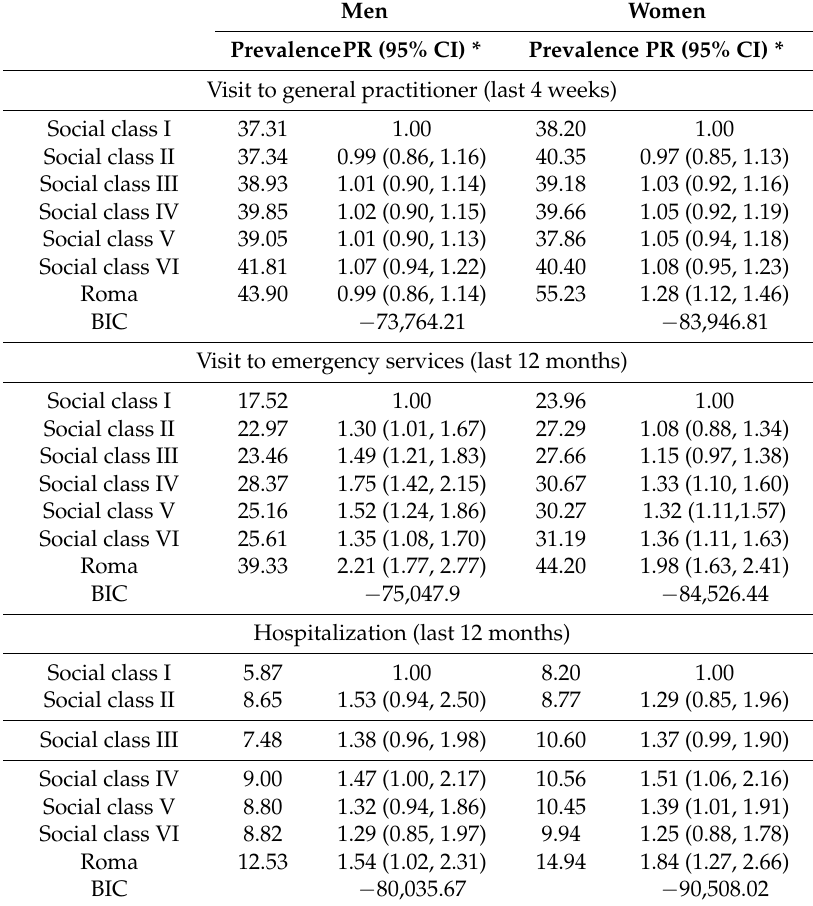
Table 1. Age-standardized prevalence (%) and prevalence ratios (with 95% CI) for the use of healthcare services by men and women according to social